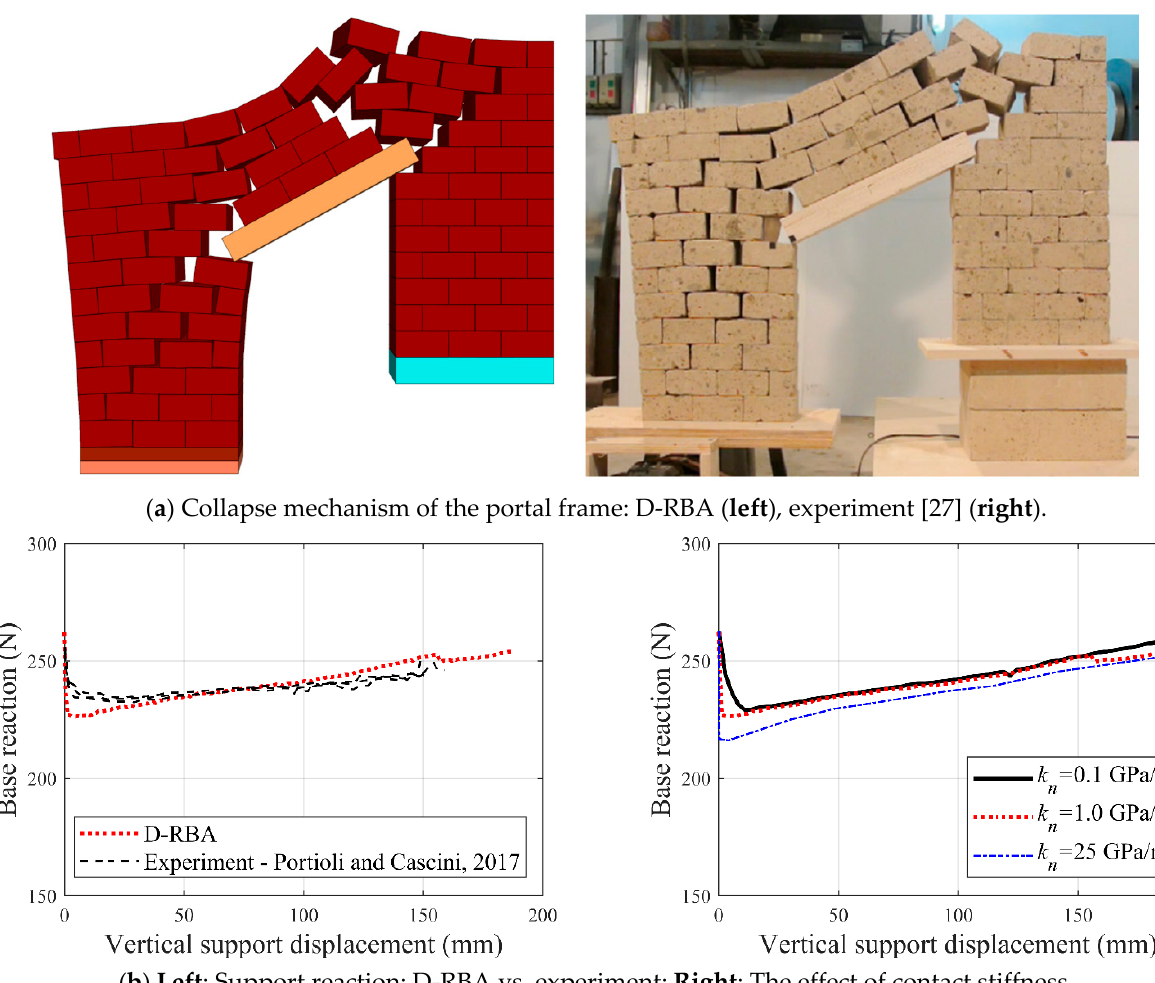
Figure 2. The results of the validation study—1: D ‐ RBA vs. experiment [26] and contact stiffness sensitivity analysis.